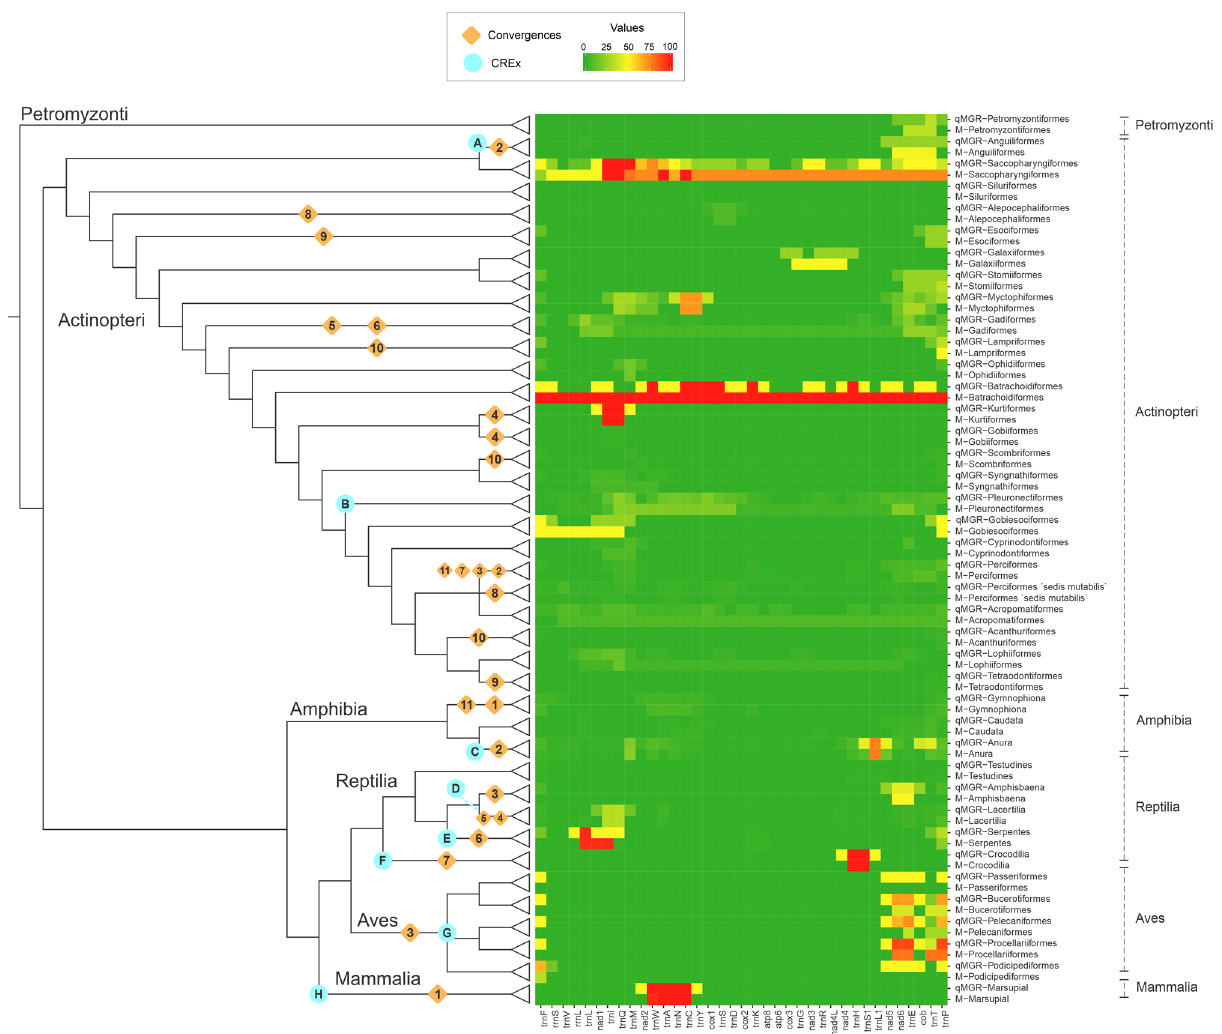
Figure 2. Heat map of gene rearrangement analysis among vertebrate classes. Phylogenetic relationships are as interpreted in Amemiya et al. 84 . Dark green colors show a low proportion of change and red colors show a high number of rearrangement events for each of the individual genes within each taxonomic order that exhibited rearrangements in mitochondrial sequences. Orange diamonds show the number of convergences detected in that taxonomic order; aquamarine blue circles indicate that a CREx representation was performed for that taxonomic